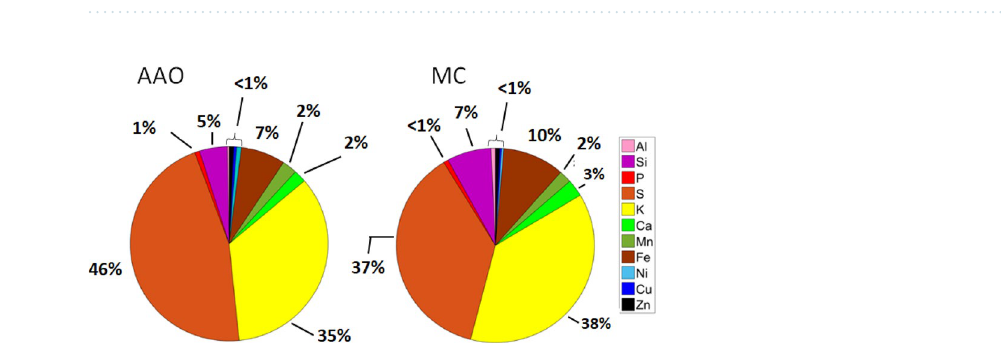
Figure 9. High-magnification TEM micrographs and EDS spectra for: ( a ) and ( b ) Tarballs; ( c ) and ( d ) Secondary aerosols particles.